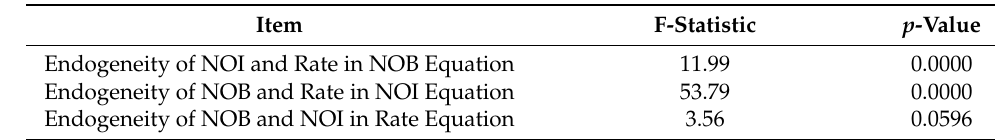
Table 8. Test of endogeneity of Equation